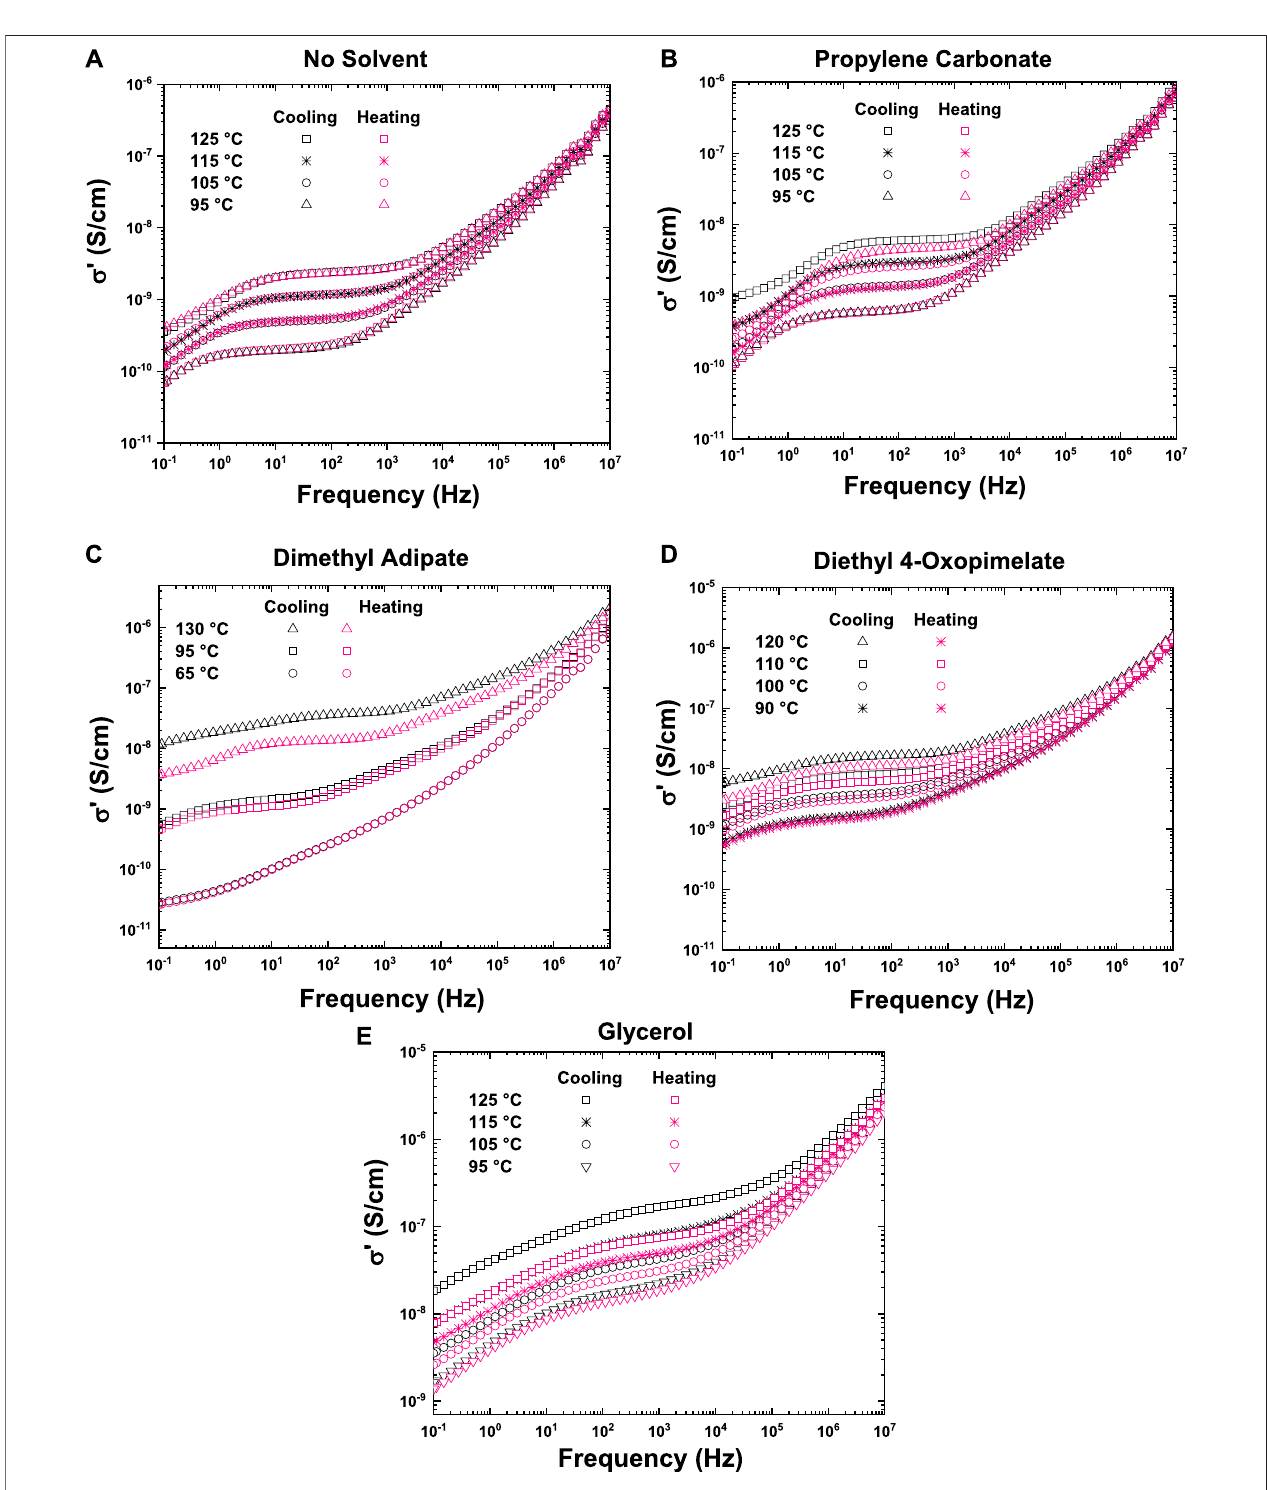
FIGURE 5 | Conductivity pro fi le as a function of frequency taken from heating and cooling cycle for unsolvated membrane (A) , propylene carbonate solvated membrane (B) , dimethyl adipate solvated membrane (C) , diethyl 4-oxopimelate solvated membrane (5 days), and glycerol solvated membrane (E) .